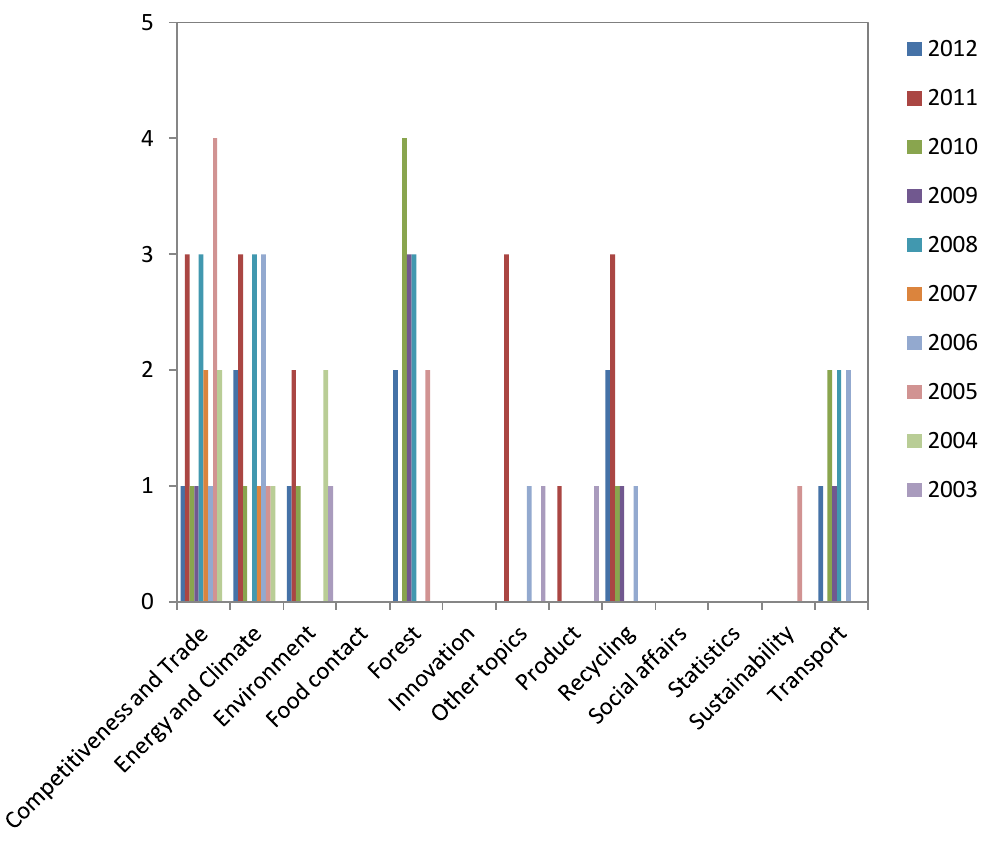
Figure 1. Issue areas of The Confederation of European Paper Industries (CEPI) position papers,